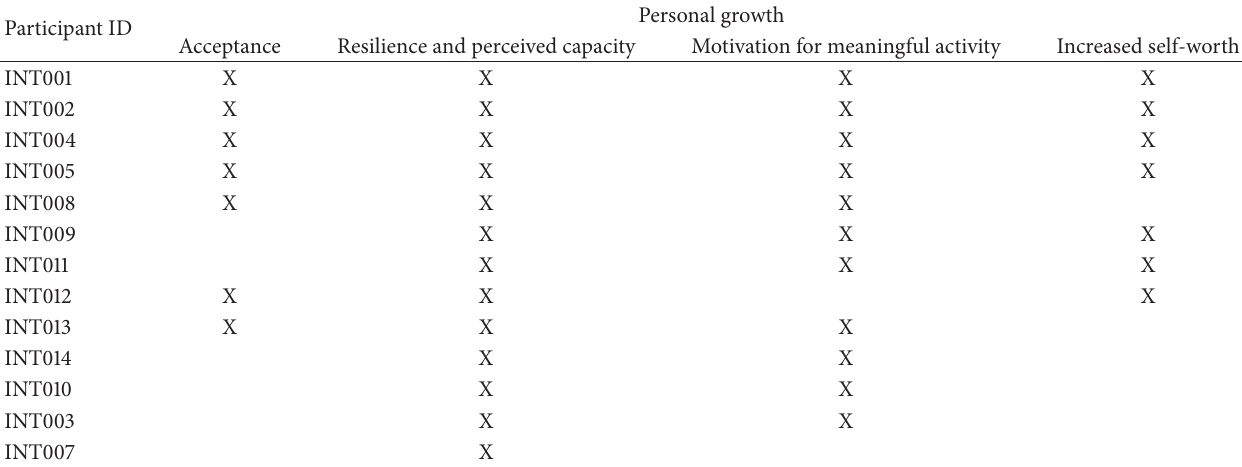
Table 2: Representation of personal growth subthemes among participant